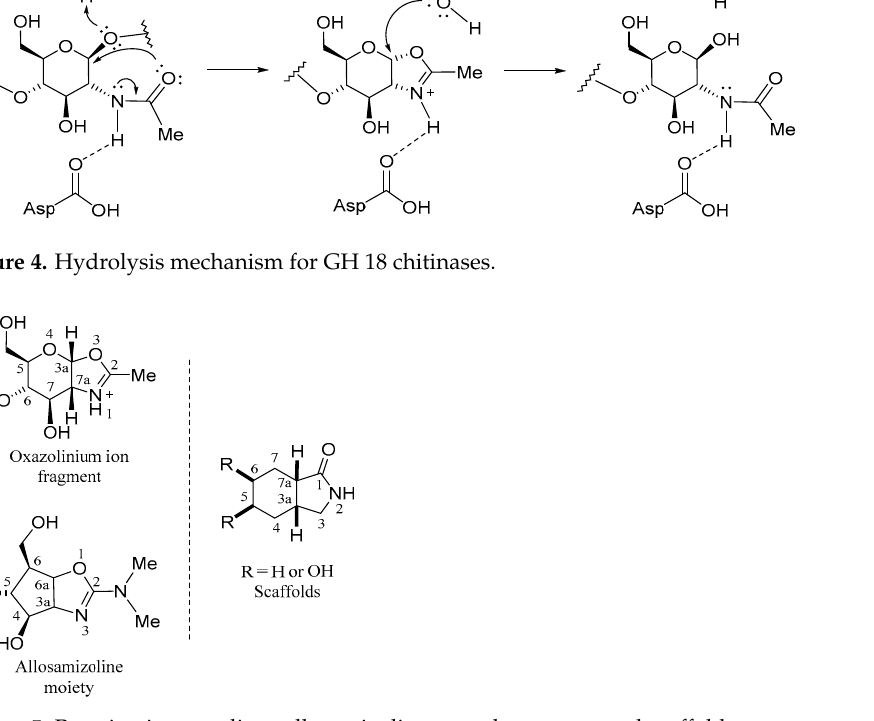
Figure 5. Reaction intermediate, allosamizoline crystal structure, and scaffold structures.